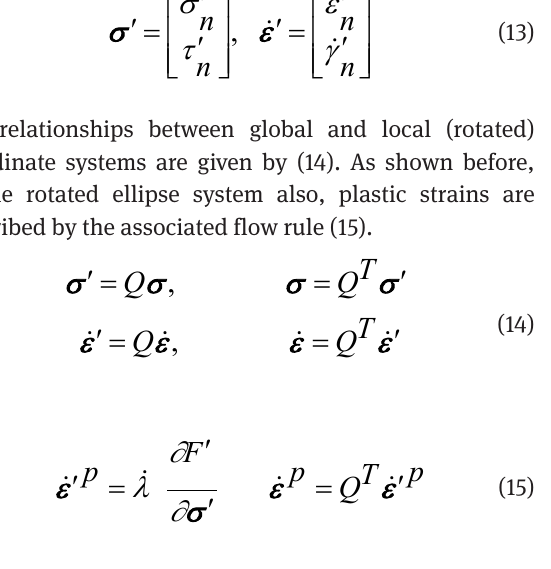
< σ < σ , ρ = 2.3 10 3 kg/m 3 , q 1 2 3 ini